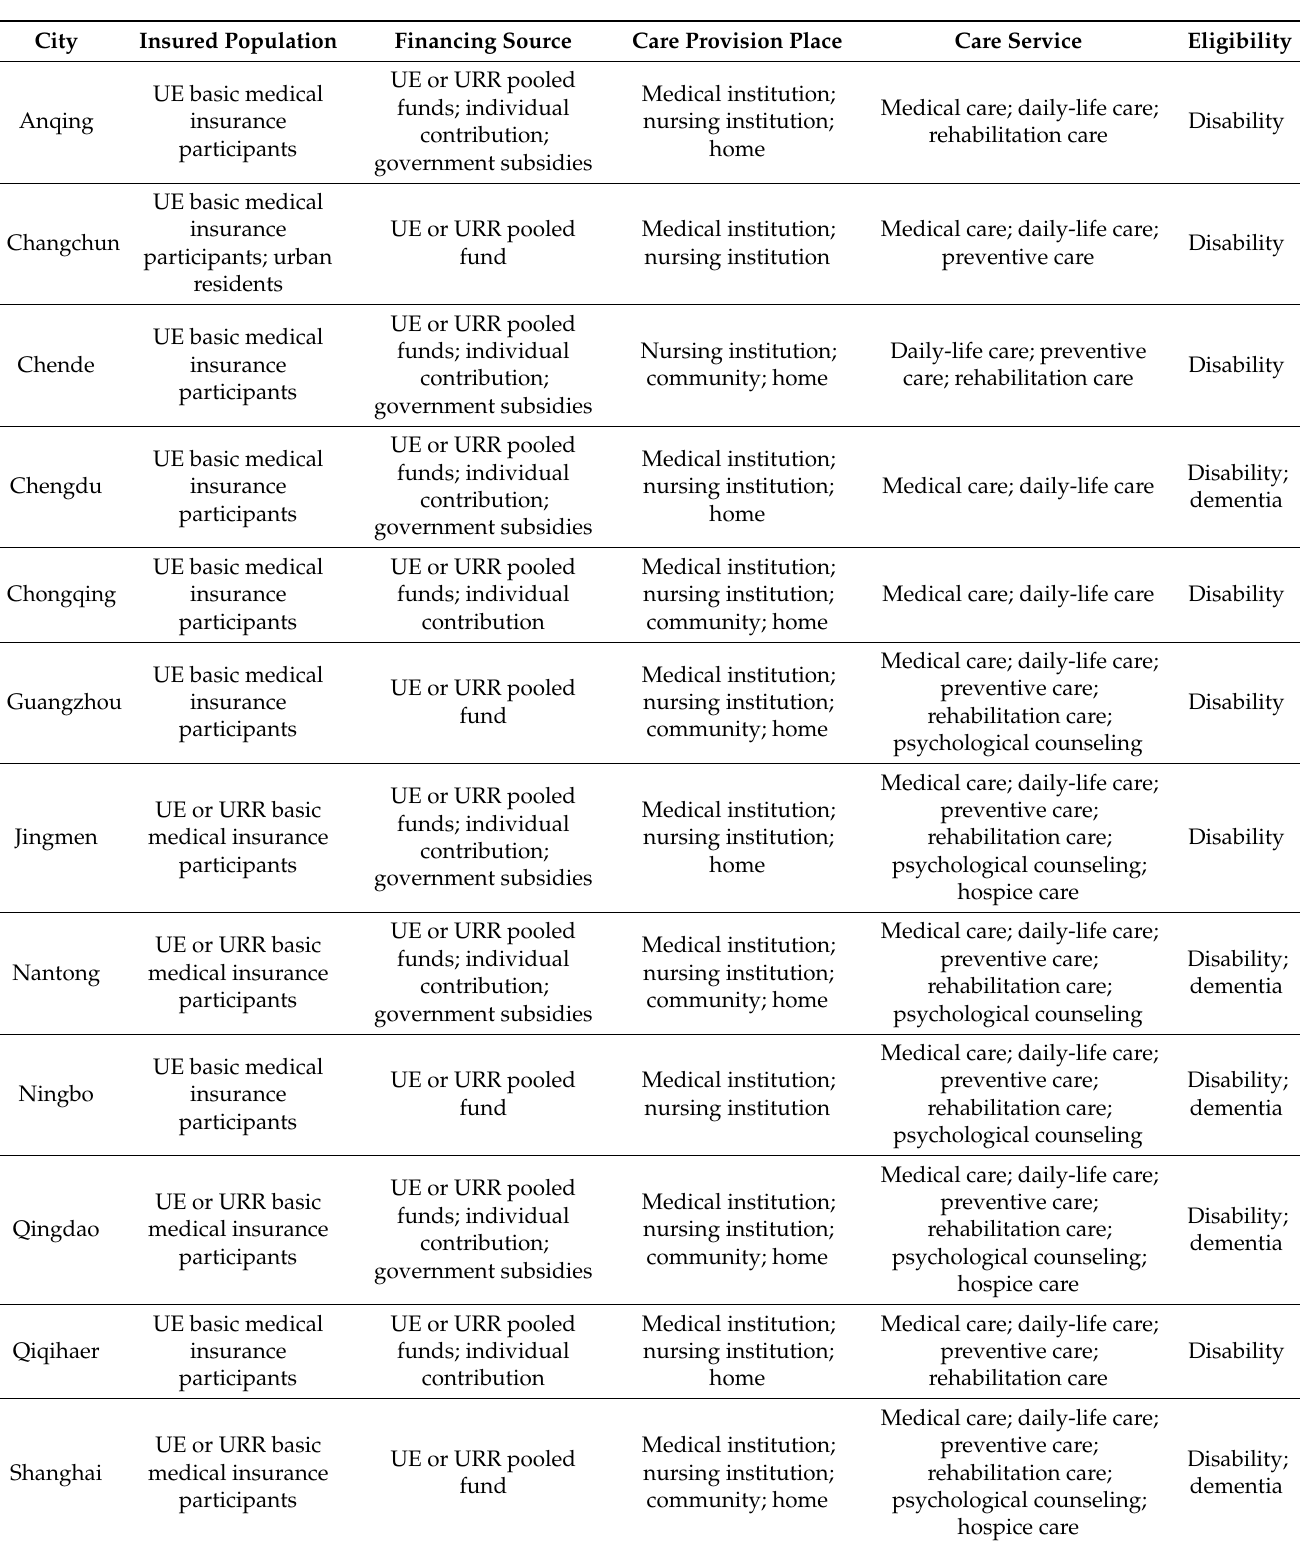
Table A1. The main contents of the LTCI policy schemes in 14 pilot